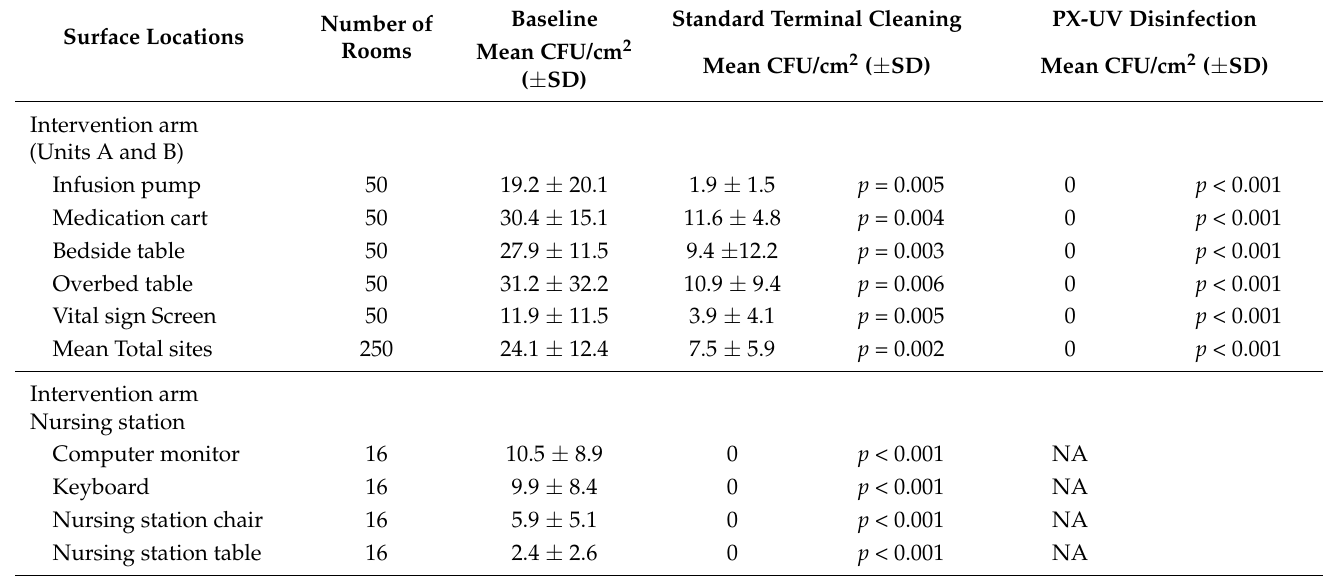
Table 2. CFU/cm 2 at baseline, after standard terminal cleaning and after PX-UV